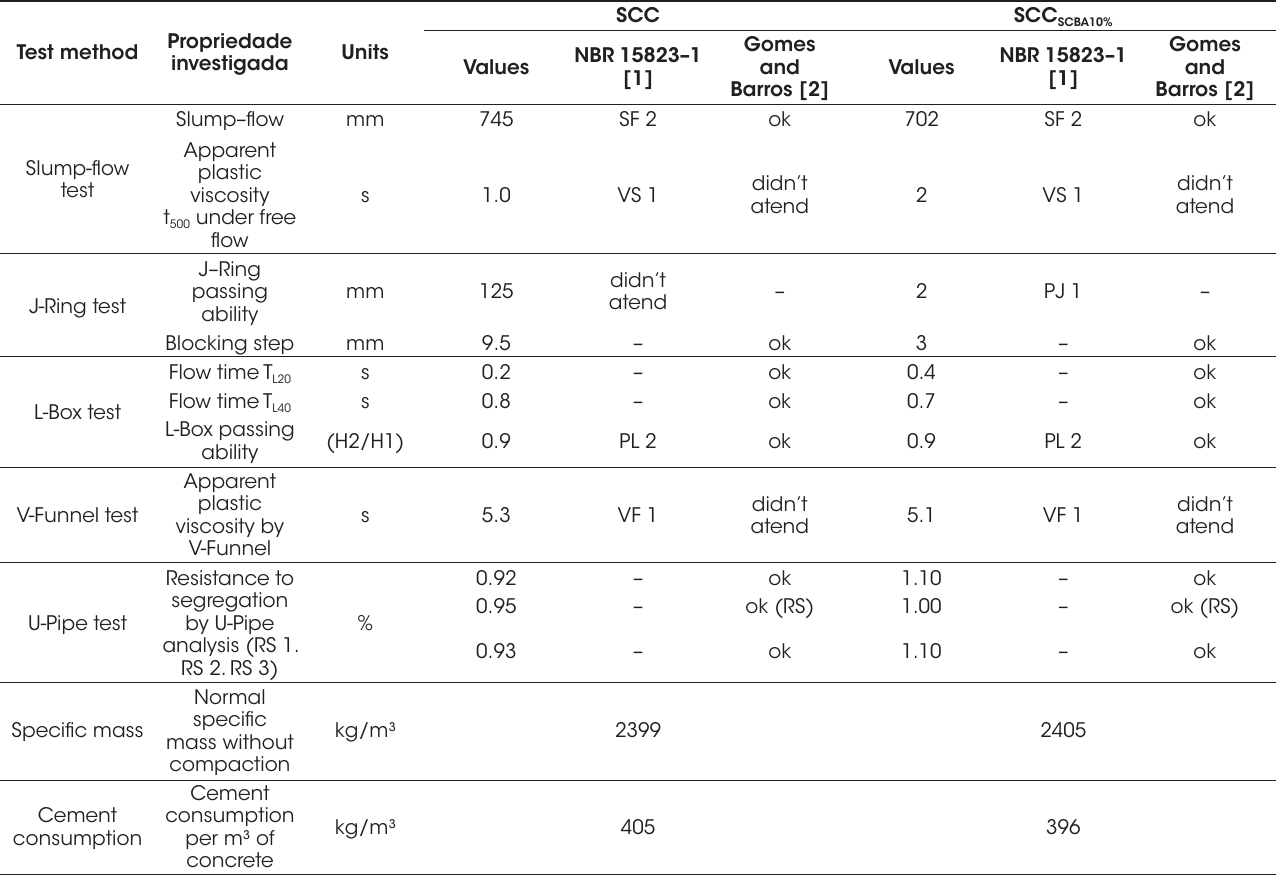
Results of the self-compactibilty